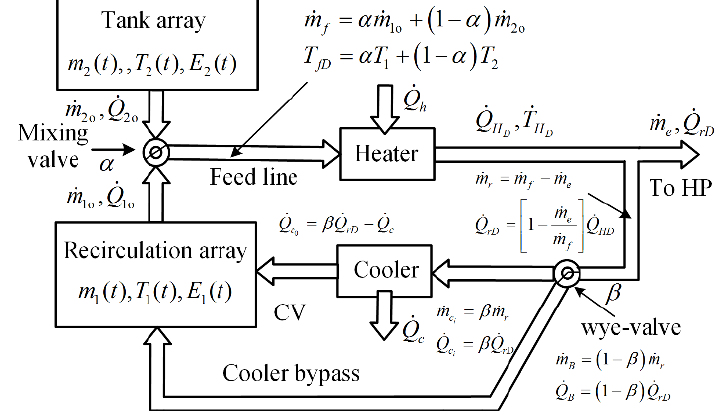
Figure 10. Dual tank topology with three inputs: feed line mixing valve ( α ), feed line flow rate ( ), cooler bypass wye valve ( β ) [72].